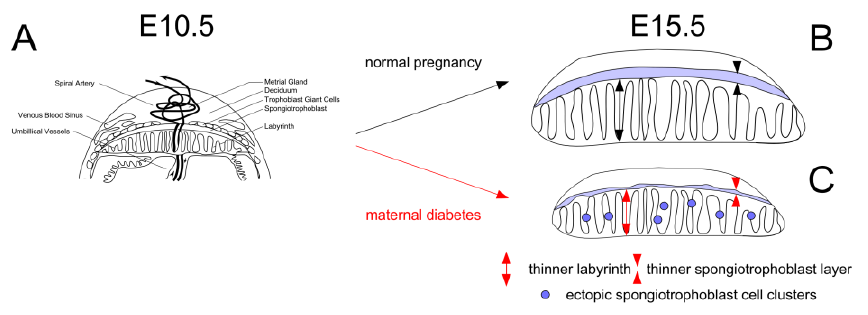
Figure 1. Overview of placental anomalies in mouse diabetic pregnancies. Panel A: Schematic depiction of the placenta at E10.5. Compared to normal pregnancies (Panel B), the placenta remains smaller in diabetic pregnancies (Panel C), with reduced thickness of labyrinth and junctional zone, and ectopic accumulation of spongiotrophoblasts in the labyrinth, due to impaired cell migration. Placenta weights were lowest in diabetic pregnancies where the dam was fed a diet (Breeder diet) that is optimized to promote pregnancy and lactation under normal